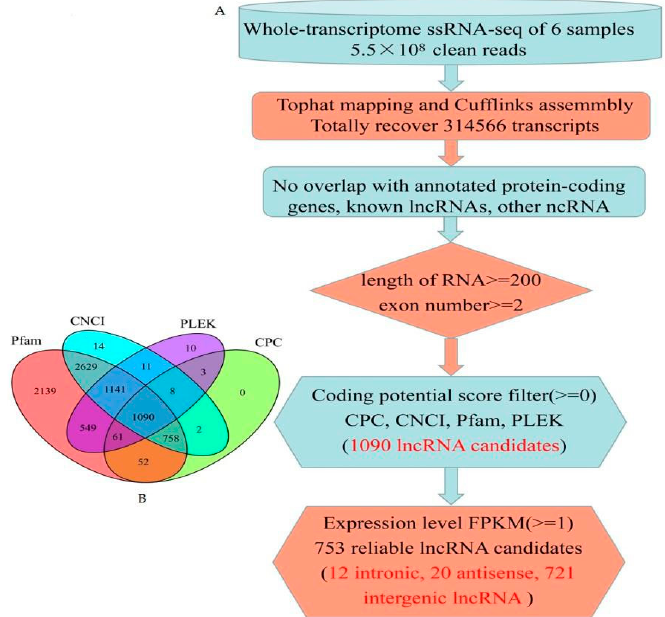
Figure 1. Informatics pipeline for the identification of maize lncRNAs. ( A ) Schematic diagram of the informatics pipeline. ( B ) Venn diagram showing the numbers of filtered potential lncRNAs by Coding Potential Calculator (CPC), Coding-Non-Coding index (CNCI), the protein family database (Pfam), and predictor of long non-coding RNAs and messenger RNAs based on an improved k-mer scheme (PLEK).